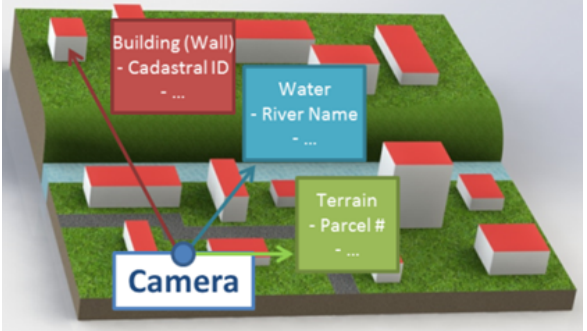
Figure 7. Three rays are generated from the viewpoint of different kinds of